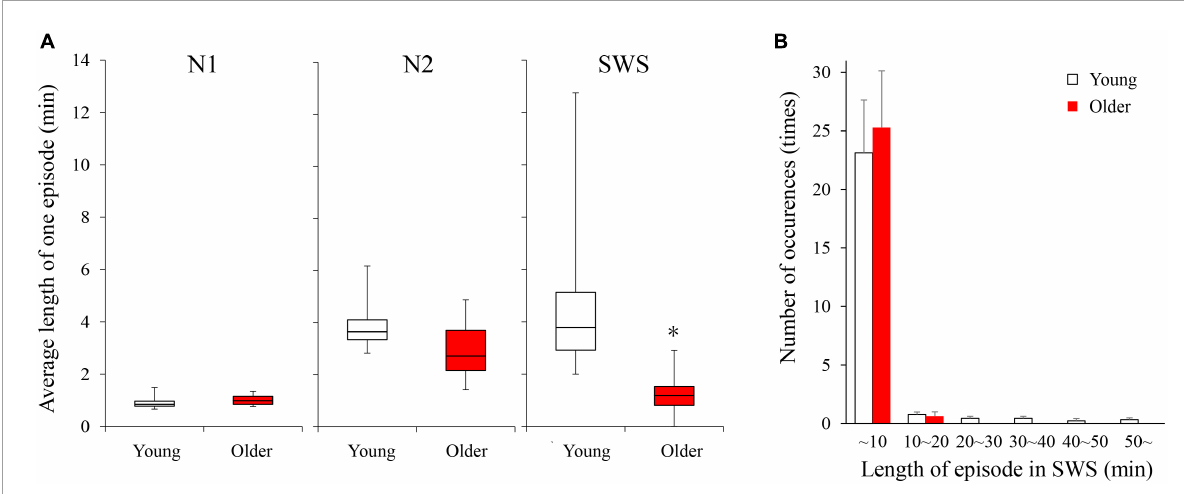
FIGURE2 Average length of 1 continuous episode of each NREM stage (A) and distribution of SWS sleep episode duration (B) . (A) A statistically significant difference between older and young groups was detected in the SWS stage with the Mann–Whitney U -test ( p < 0.001). (B) Although total numbers of SWS episodes were identical between the 2 age groups, older subjects did not have any episodes longer than 16 min. Asterisk represents a statistically significant difference between the older and young subjects ( p < 0.05).